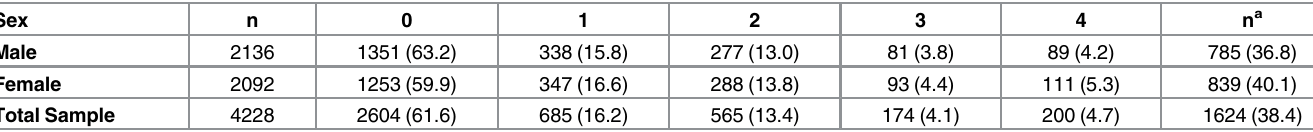
Table 1. Distribution of subjects with third molar presence/agenesis in Bangladeshi